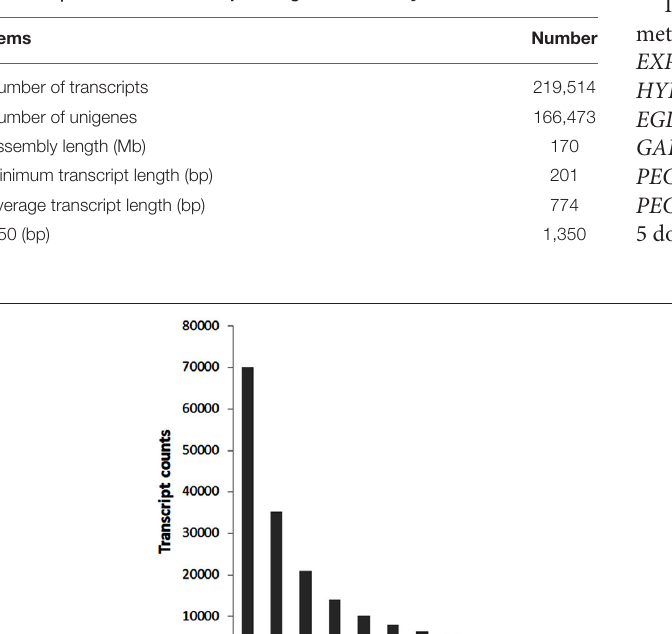
TABLE 1 | Statistics of the sequencing and assembly.